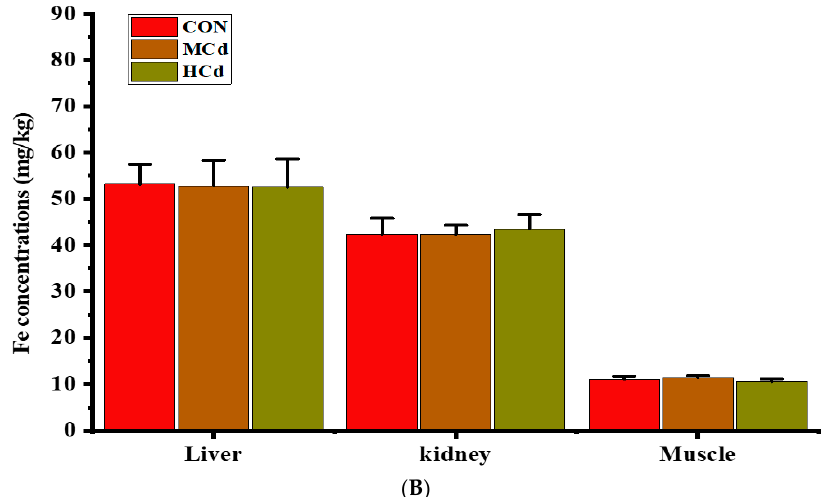
Figure 3. Effects of dietary cadmium levels on ( A ) cadmium and ( B ) iron concentrations in the liver, kidney, and muscle of goats. Different letters (a, b, c) indicate significant difference a significant difference among the three dietary treatments at p < 0.05. Values are expressed as the mean ± SEM. One-way ANOVA was used, followed by post hoc Tukey’s test. n = 8. ND = Not detected (below the